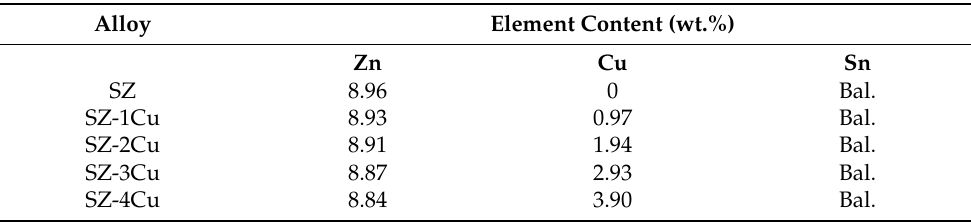
Table 1. Chemical composition of the experimental Sn-9Zn- x Cu alloys analysed by inductively coupled plasma atomic emission spectroscopy (ICP-AES), wt.%. Alloy Element Content (wt.%) Zn Cu Sn SZ 8.96 0 SZ-1Cu 8.93 0.97 SZ-2Cu 8.91